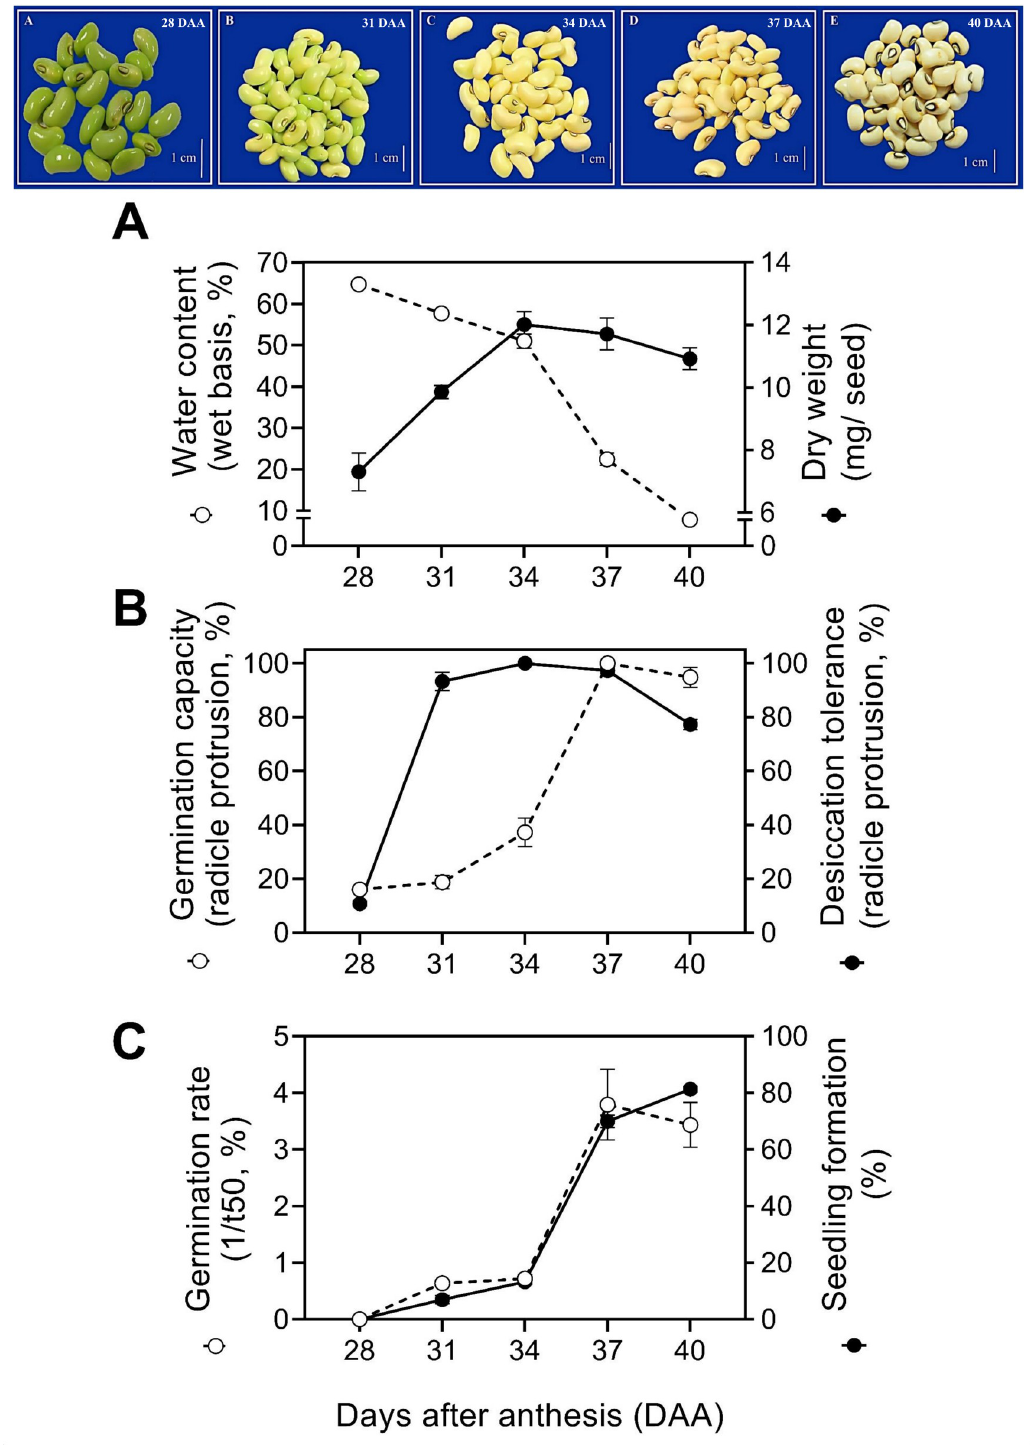
Fig 1. Physical and physiological changes of cowpea ( Vigna unguiculata L., Walp) seeds at 28, 31, 37 and 40 days after anthesis (DAA). A: Water content and dry weight. B: germination capacity (fresh seeds) and desiccation tolerance (dried seeds). C: vigor expressed by germination rate (1/t50) and seedling formation (aerial part, hypocotyl and radicle well developed and healthy).